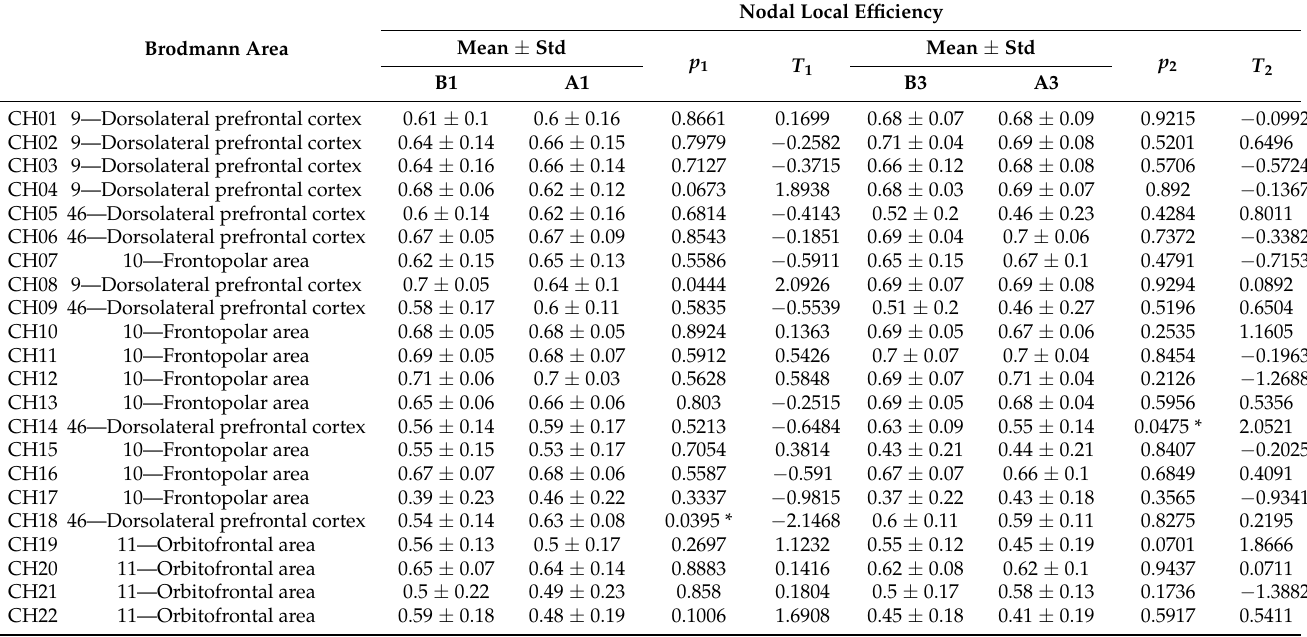
Table 5. Group differences in nodal local efficiency during resting